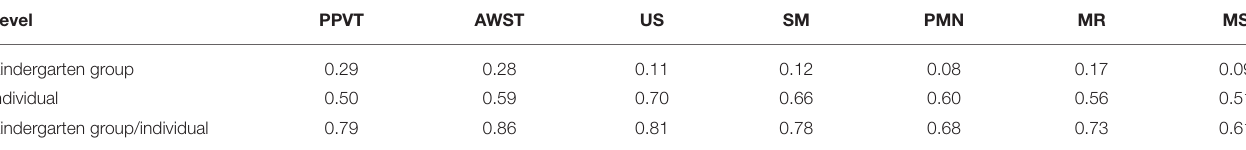
TABLE 4 | ICCs of random effects at kindergarten group level, individual level, and both levels for each outcome